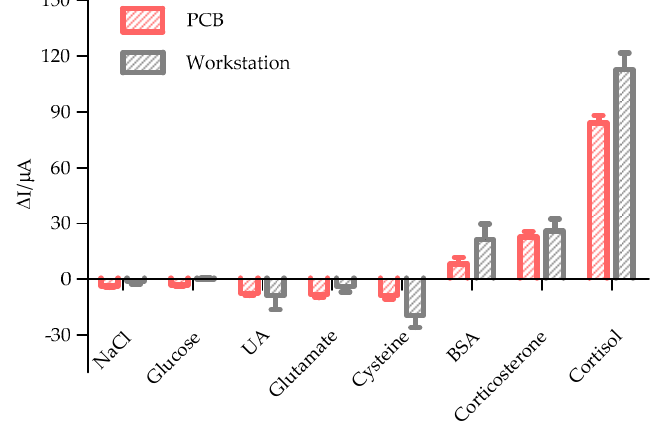
Figure A3. Selective responses of cortisol and substances existed in saliva using the smartphone-controlled DPV system (red box) and the electrochemical workstation (grey box).